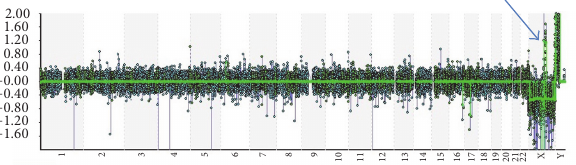
−1.60 Figure 3: Oligoarray CGH results. Note the arrow shows duplica- tion on